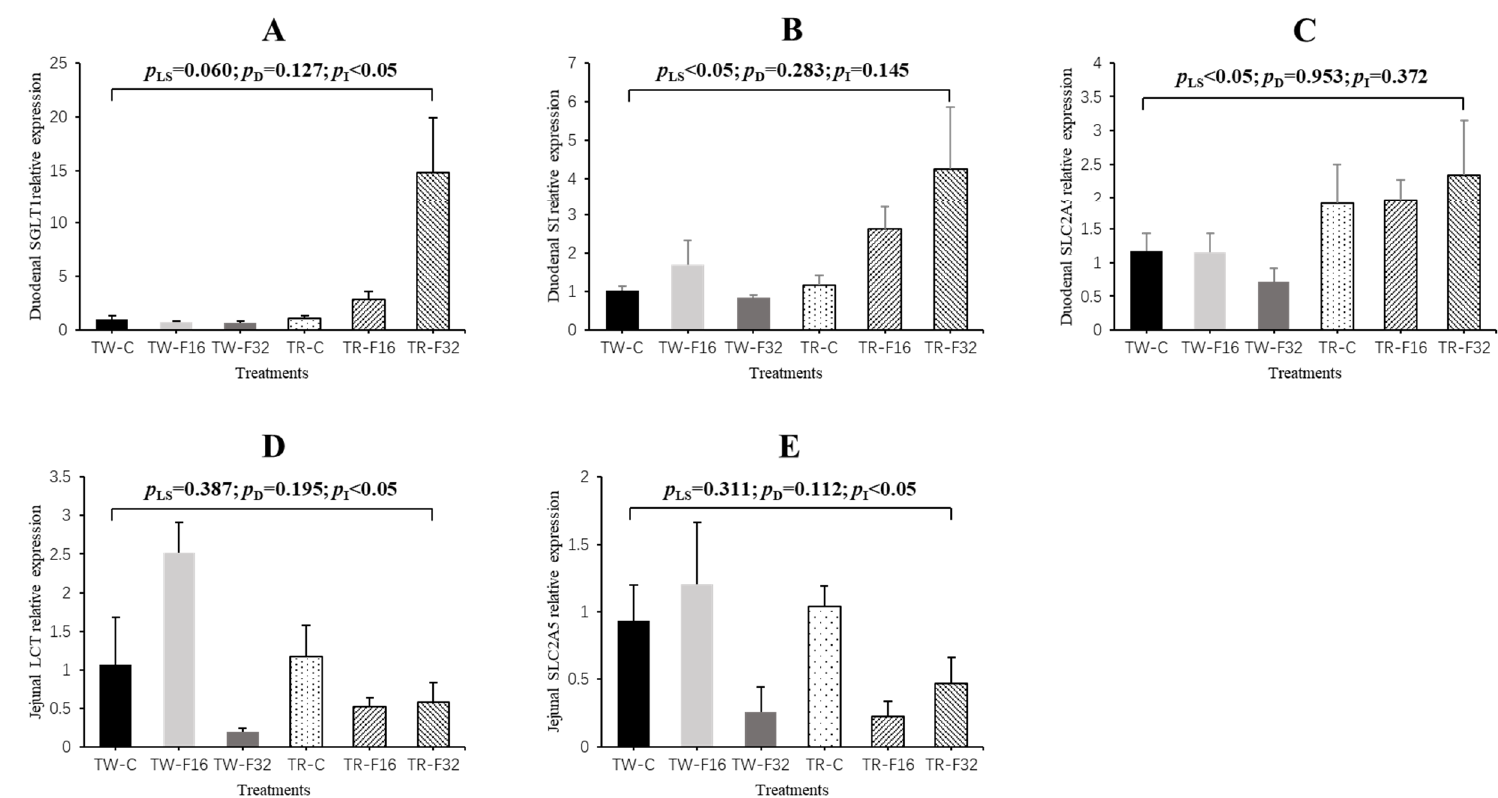
Figure 5. The duodenal gene expression of SGLT1 ( A ), SI ( B ), SLC2A5 ( C ) and jejunal gene expression of LCT ( D ) and SLC2A5 ( E ) a ff ected by maternal folic acid supplementation. TW-CON, TW-F16 and TW-F32, twins born from ewes fed 0, 16 or 32 mg · (kg DM) − 1 folic acid in the control diet, respectively; TR-CON, TR-F16 and TR-F32, triplets born from ewes fed 0, 16 or 32 mg · (kg DM) − 1 folic acid in the control diet, respectively. p LS , p -value of litter size; p D , p -value of diet folic acid supplementation; p I , p -value of interaction e ff ects between litter size and folic acid supplementation.